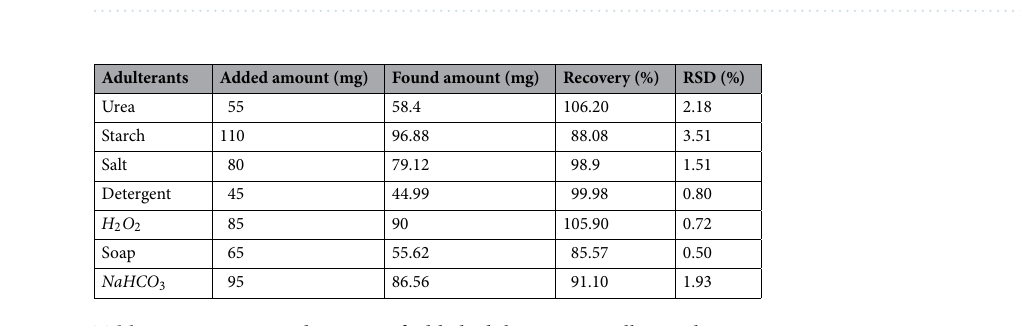
Table 2. Quantitative detection of added adulterants in milk